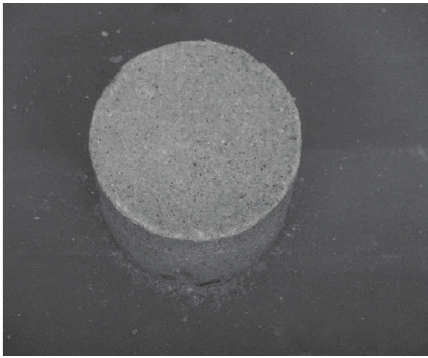
Figure 8: Improved samples immersed in water for 48 h at 2nd cycle of wetting-drying.